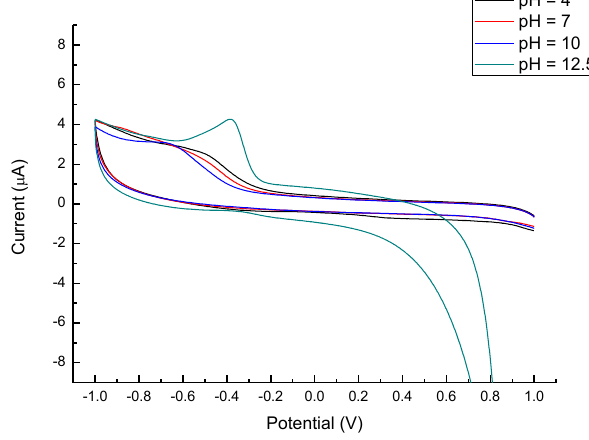
Figure 9. CV profile of ZnO@C/GC electrodes under different pH values.